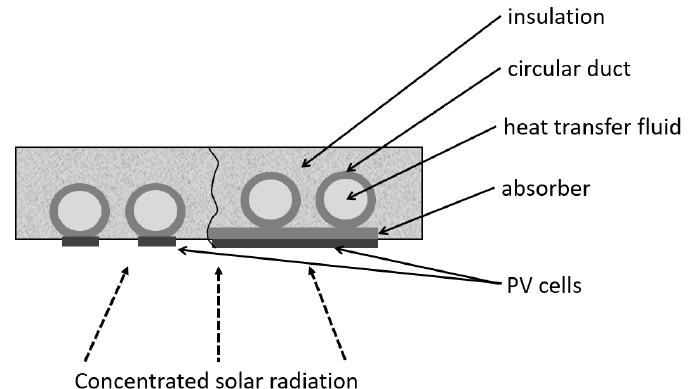
Figure 20. The cross-sectional view of a heat receiver with serpentine ducts—with direct and indi- rect connection between PV cells and cooling ducts. connection between PV cells and cooling